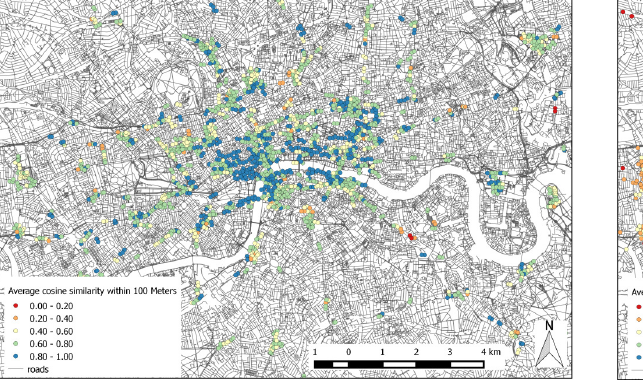
Figure 9: Average cosine similarity within 100 meters